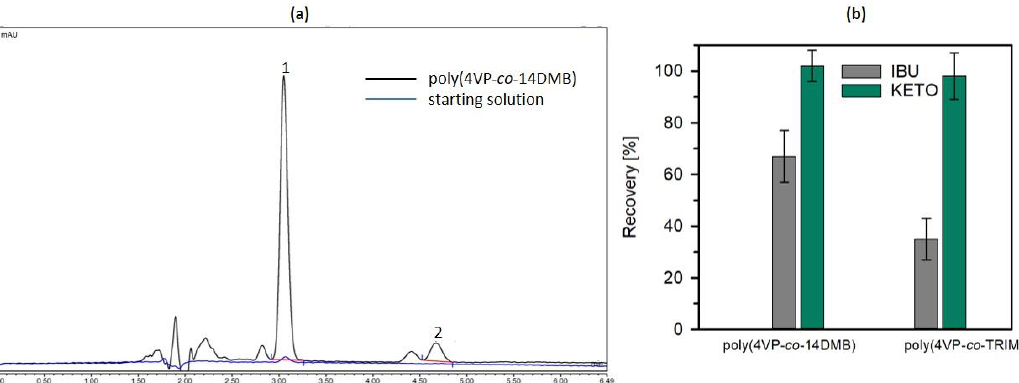
Figure 10. Chromatograms recorded for initial and preconcentrated on poly(4VP- co -14DMB) solutions of ketoprofen (1) and ibuprofen (2) ( a ). Recoveries of target compounds obtained after extraction with 4VP sorbents ( b ); (mean (bar) ± standard deviation (whisker) ( n = 3)).